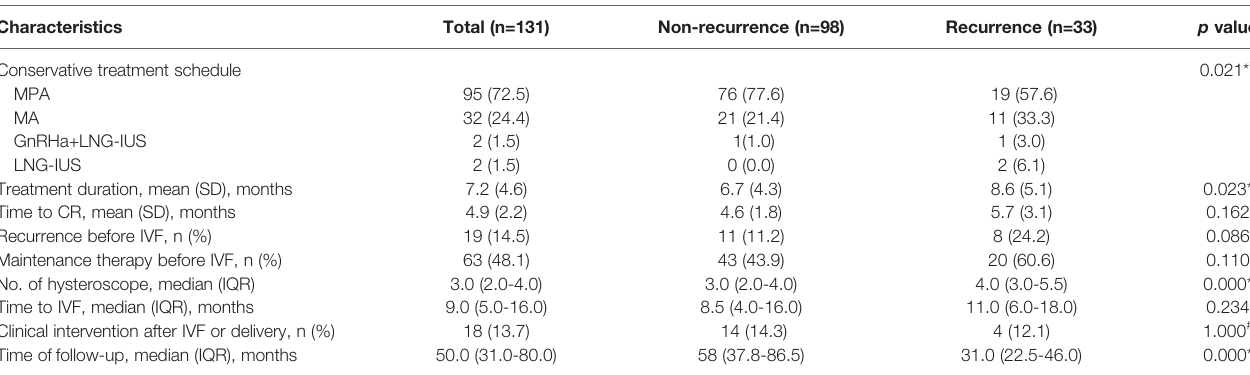
TABLE 2 | Characteristics of conservative treatment of the analysis